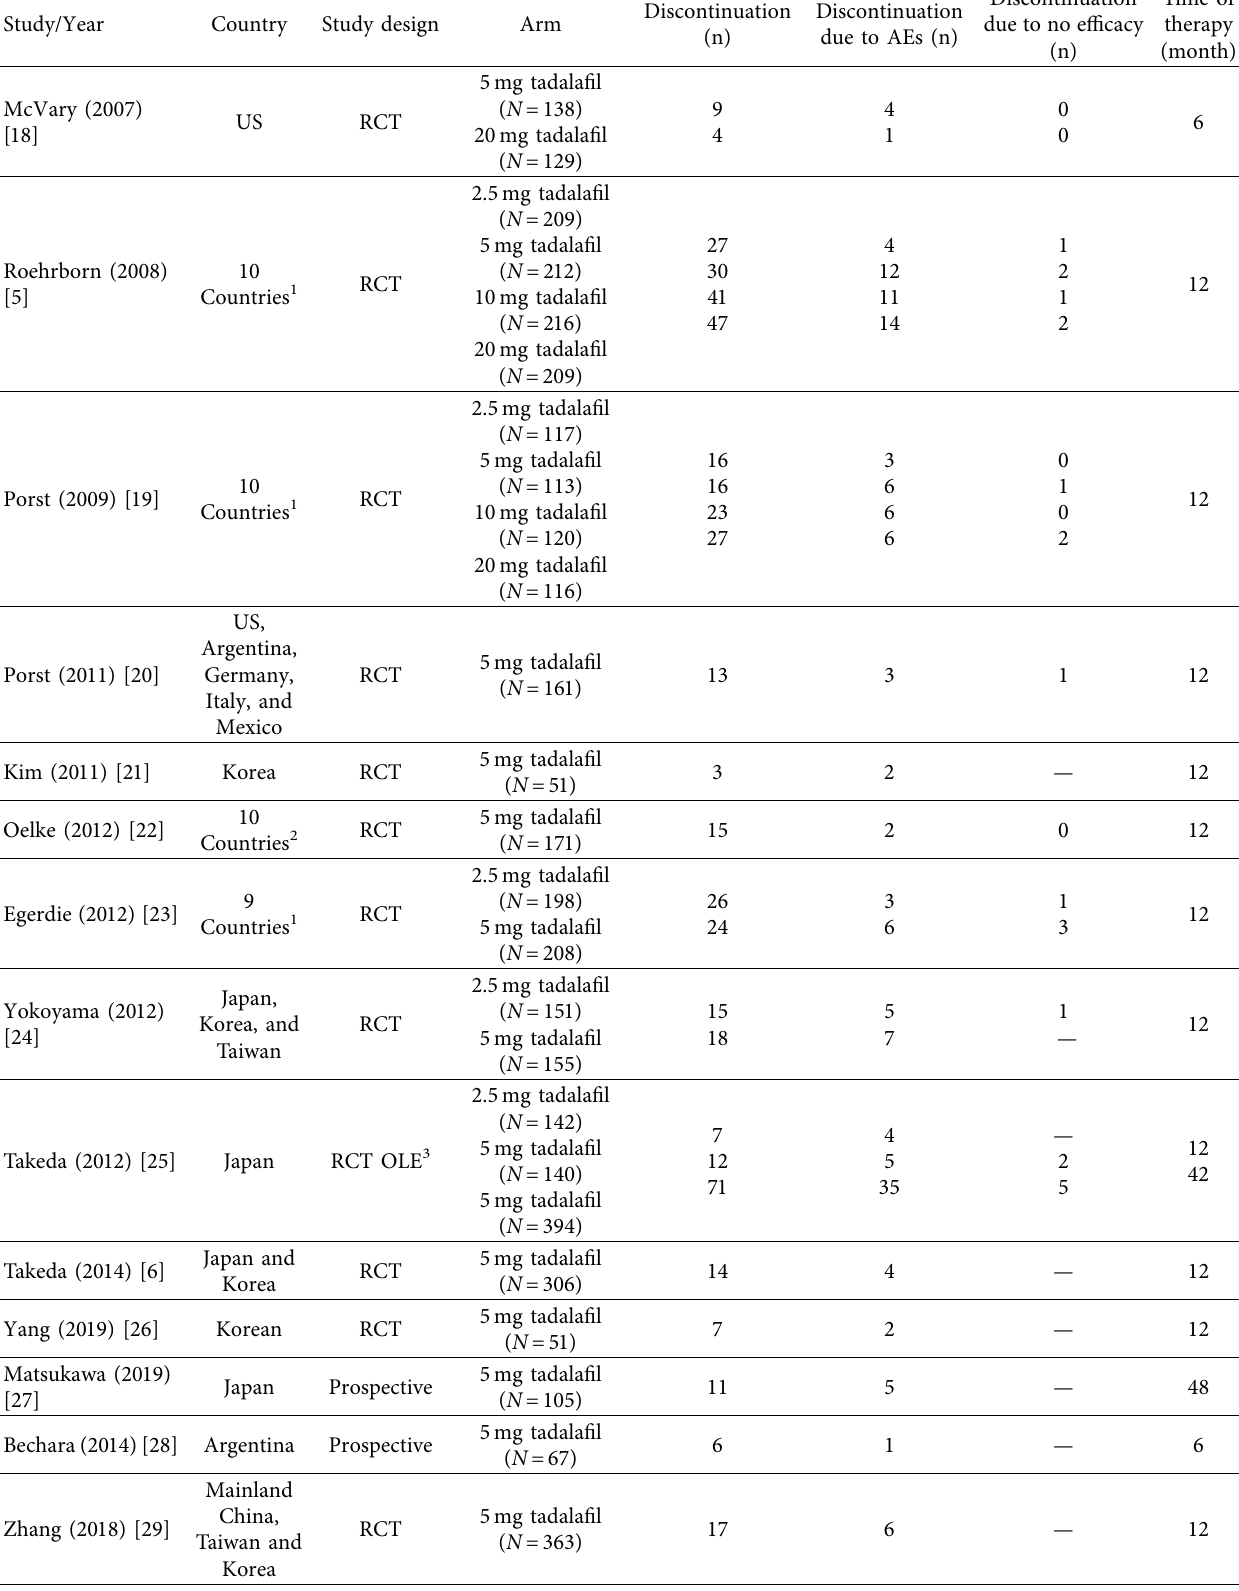
Table 1: Baseline characteristics of the included